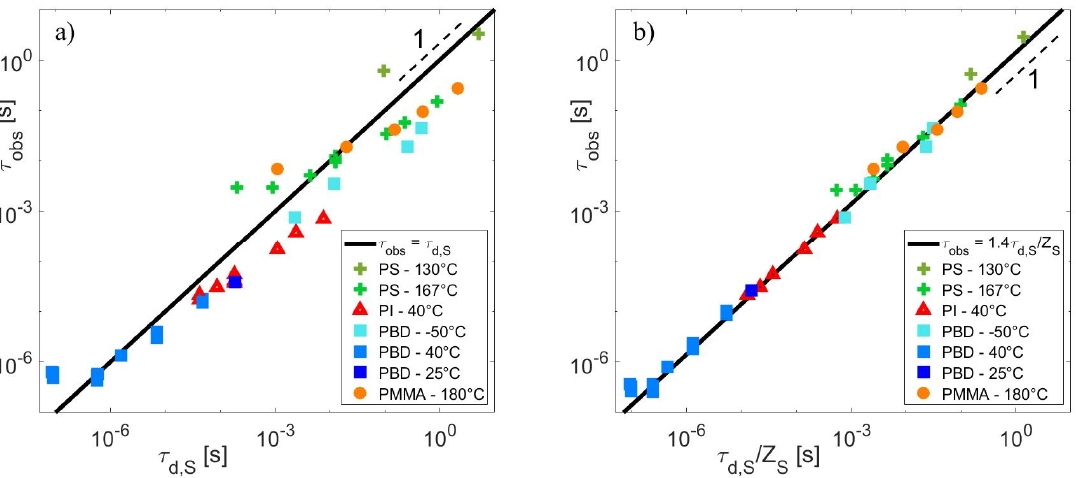
Figure 10. 𝜏 (cid:3042)(cid:3029)(cid:3046) versus 𝜏 (cid:3031),(cid:3020) ( a ) or 𝜏 (cid:3031),(cid:3020) /𝑍 (cid:3020) ( b ) for several self-unentangled blends of different poly- Figure 10. τ obs versus τ d , S ( a ) or τ d , S / Z S ( b ) for several self-unentangled blends of different polymer chemistries, from Refs. [14,24–28,30,40,41] and measured in this